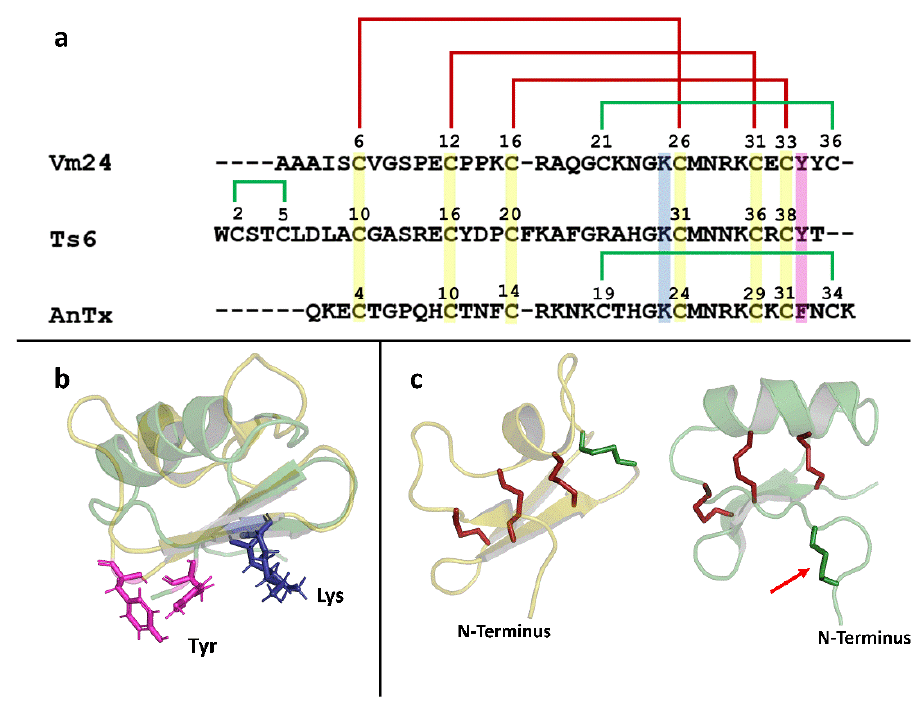
Figure 7. Structural analysis of Vm24, Ts6, and AnTx. ( a ) Sequence alignment of Vm24, Ts6, and AnTx. Conserved Cys between the three peptides are highlighted in yellow; the functional dyad is highlighted in blue and pink. Conserved disulfide bridges are shown in red; the extra disulfide bridges are shown in green. ( b ) Structural alignment between Vm24 and Ts6. Vm24 structure is shown in yellow (PDB:2K9O); Ts6 structure is shown in green (PDB:1C56); functional dyads are shown in the structural alignment as sticks, lysine (blue) and tyrosine (pink). ( c ) Disulfide pattern of Vm24 and Ts6. Conserved disulfide bridges are shown in red sticks; the other disulfide bridges are shown in green. The red arrow points to the disulfide bridge found in the N-terminus of Ts6.